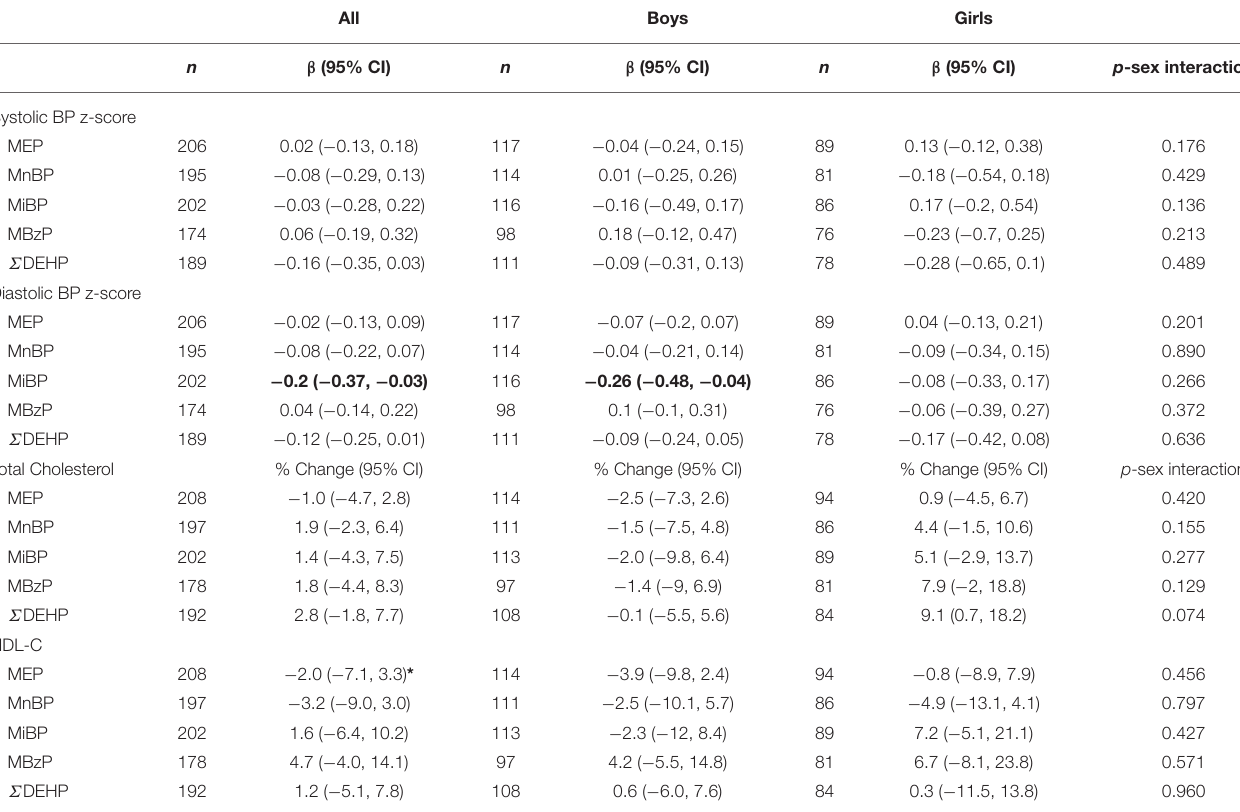
TABLE 3 | Sex-stratified associations between prenatal urinary individual and summed Σ DEHP phthalate metabolites (log 10 Transformed, in µ g/g Creatinine) with lipids and blood pressure levels in children aged 4–6 years. All Boys Girls n β (95% CI) p -sex interaction Systolic BP